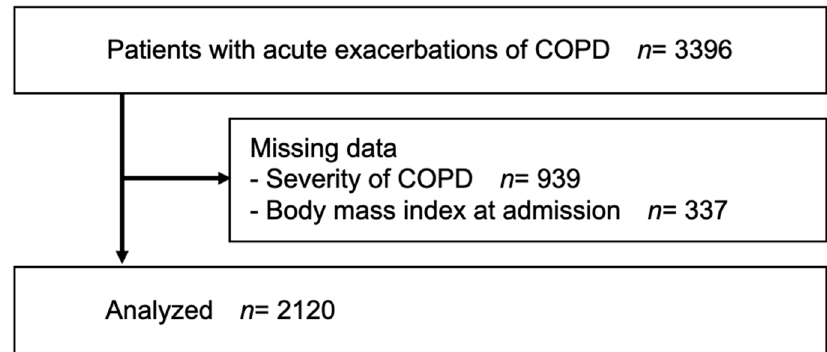
Figure 1. Flowchart of the sample size in this study.